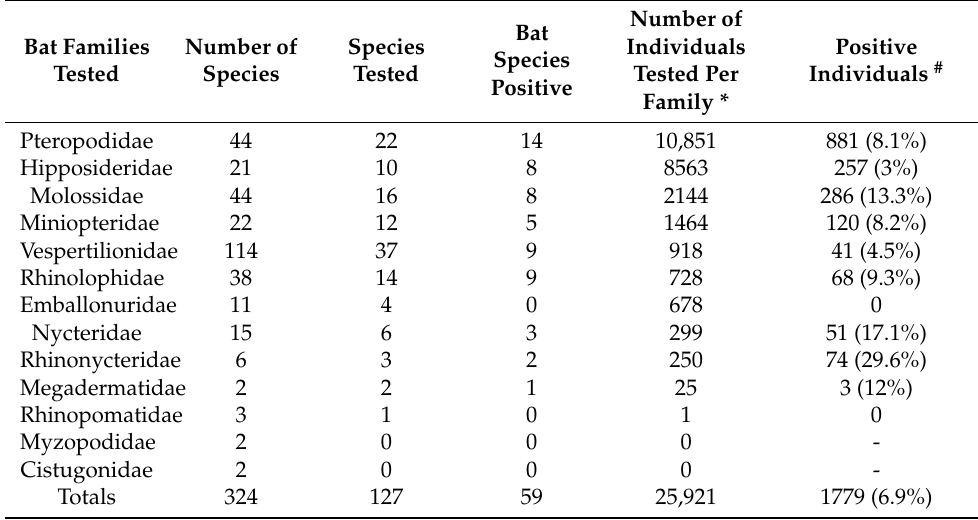
Table 3. Coronavirus detections according bat host